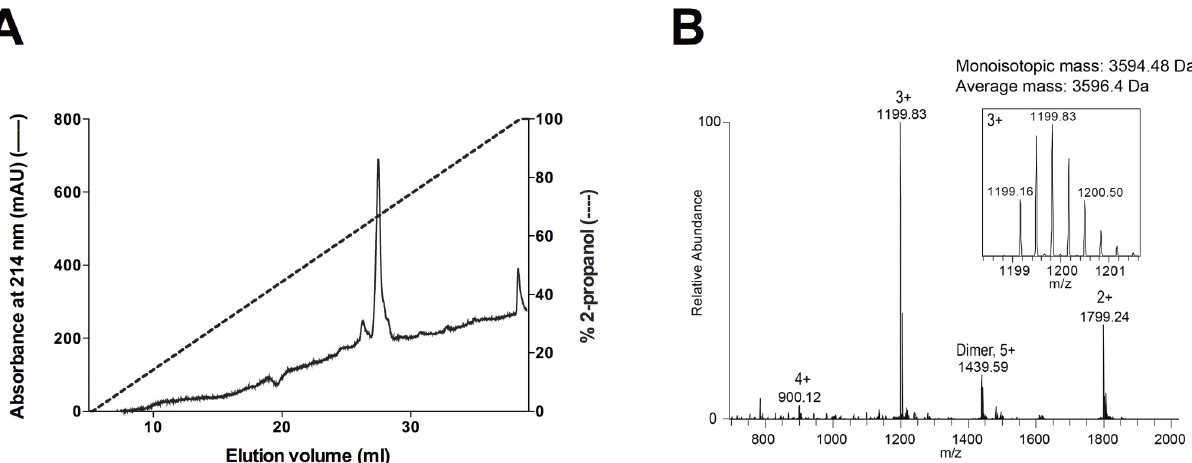
Fig 3. High-performance liquid chromatography and mass spectrometry of Lipidex-5000 purified rSP-C33Leu. The peptide obtained from the second Lipidex-5000 column (Fig 2B and 2D, fractions 4 and 5) was analyzed by RP-HPLC (A) and mass spectrometry (B). The close-up on the 3 + charge state show 0.33m/z intervals.